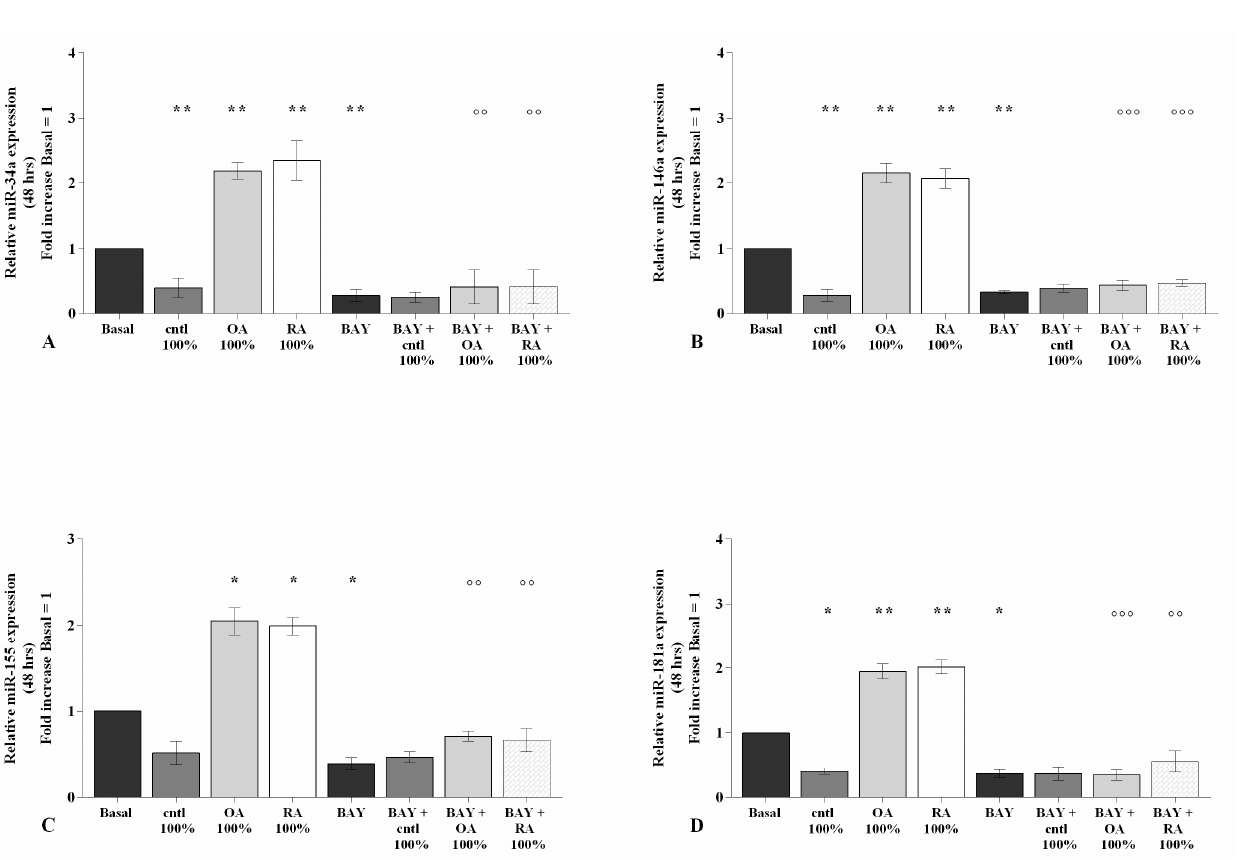
Figure 7. SF modulates the NF- κ B pathway. Human osteoarthritic (OA) chondrocytes were pre- incubated for 3 h with a specific nuclear factor (NF)- κ B inhibitor (BAY 11-7082, IKK α / β , 1 µ M), and then for 48 h with 100% SF derived from patients with OA, rheumatoid arthritis (RA), or controls. ( A – D ) Expression levels of microRNA ( miR ) -34a , miR-146a , miR-155 , and miR-181a analyzed by quantitative real-time PCR. The gene expression was referenced to the ratio of the value of interest and the value of basal condition, reported equal to 1. Data were represented as mean ± SD of triplicate values. * p < 0.05, ** p < 0.01, versus basal condition. ◦◦ p < 0.01, ◦◦◦ p < 0.001 versus control SF.